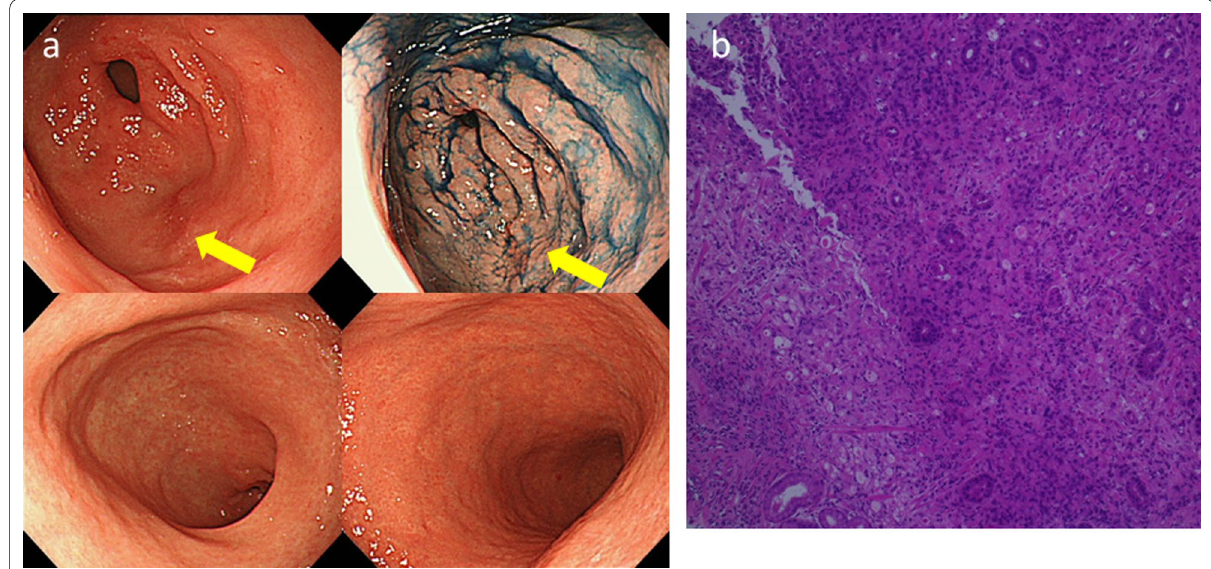
Fig. 3 Esophagogastroduodenoscopy and pathological findings in the stomach. a Esophagogastroduodenoscopy showed limited rough-surfaced mucosa with slight redness changes near the pyloric ring (arrow) that stained positive for indigo carmine staining (arrow). There were no specific signs in other areas of antrum and gastric body. b Biopsy specimens revealed a poorly differentiated adenocarcinoma with signet-ring cells (